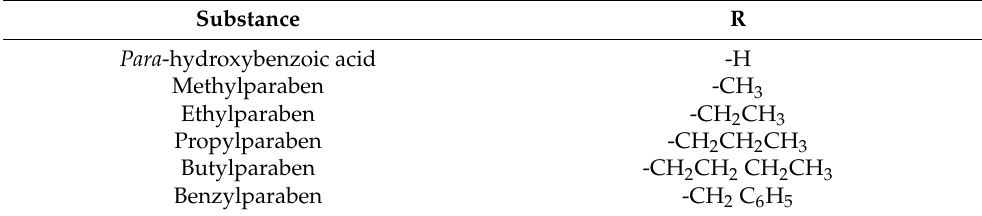
Figure 2. Common chemical structure of parabens. Table 2. Chemical structure of different parabens.